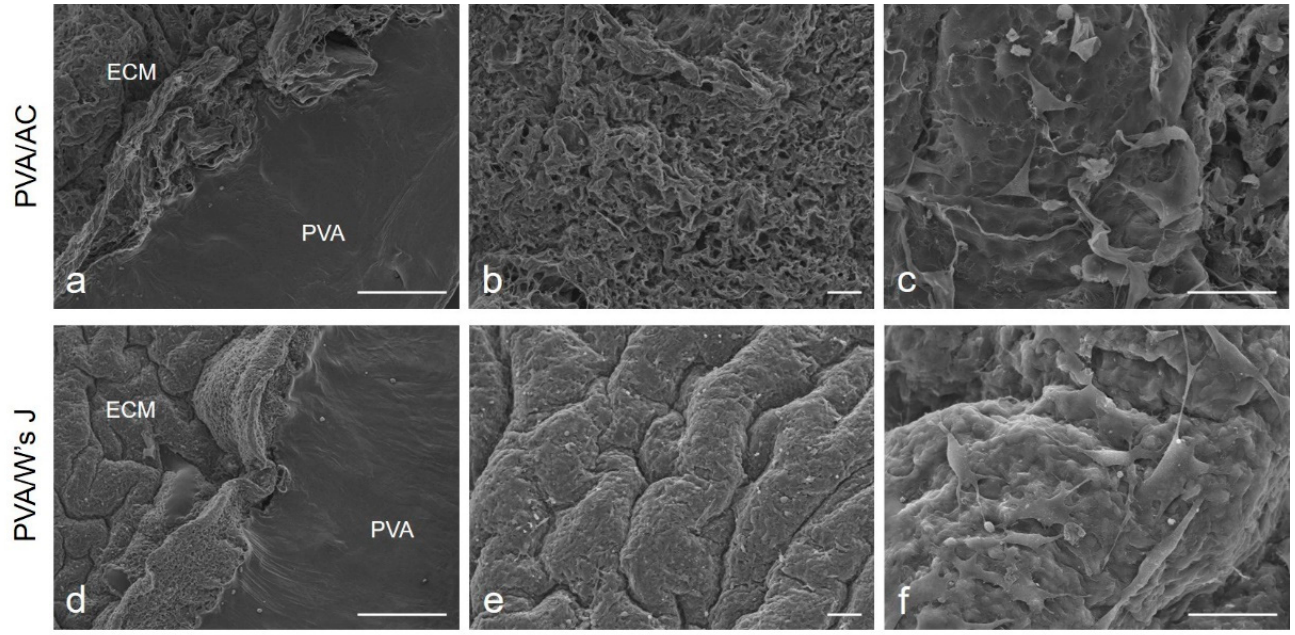
Figure 4. Scanning electron microscope micrographs of bi-layered composite scaffolds made of PVA and AC ( a – c ) or Wharton’s jelly (W’s J) ( d – f ) ECM, seeded with human chondrocytes for 7 days. Scale bar: ( a , d ) 500 µ m; ( b , e ) 100 µ m; ( c , f ) 50 µ